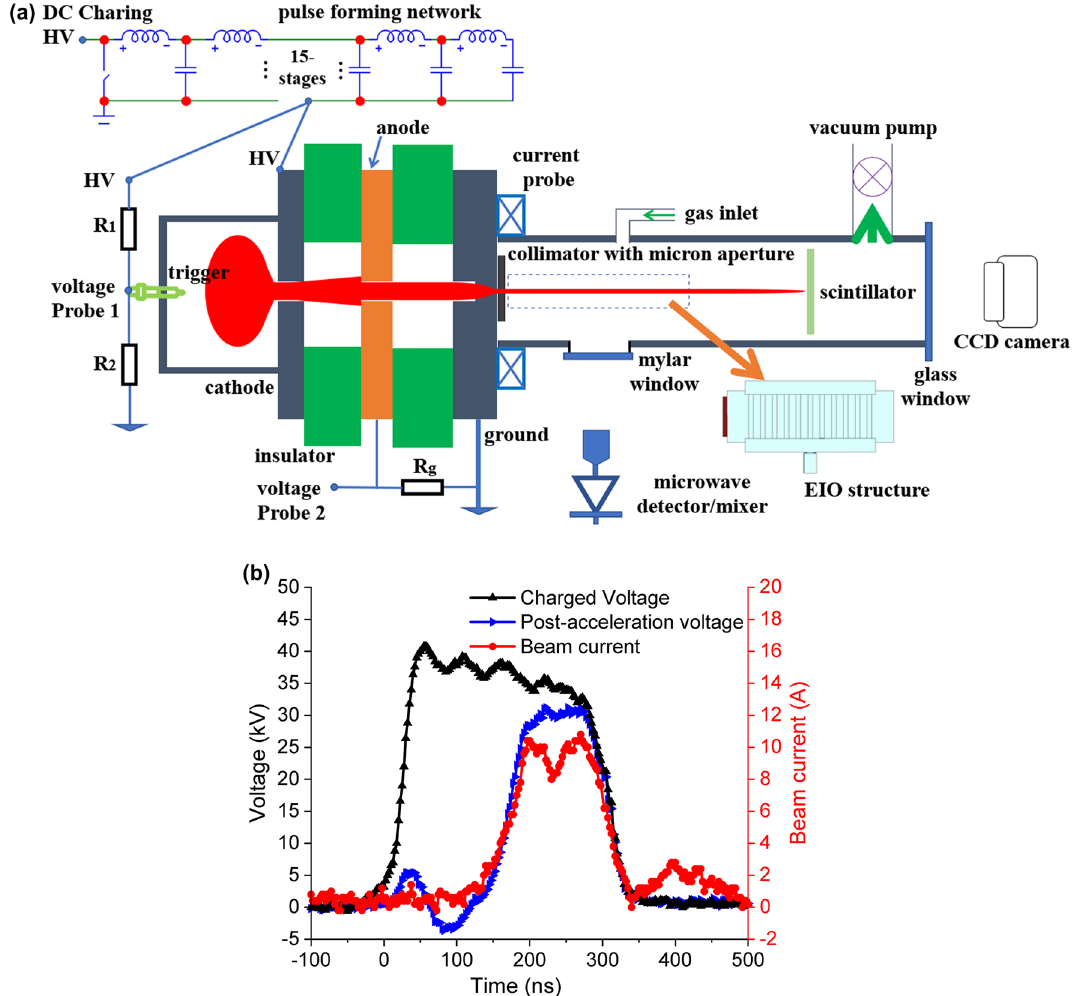
Figure 5. ( a ) The schematic drawing of the hollow-cathode discharge experimental setup with post- acceleration, and ( b ) The waveforms of the discharge voltage and acceleration voltage